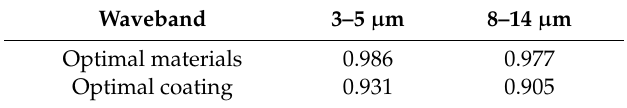
Table 9. Emissivities of Cu x Co 1 − x Fe 2 O 4 series infrared radiation material and